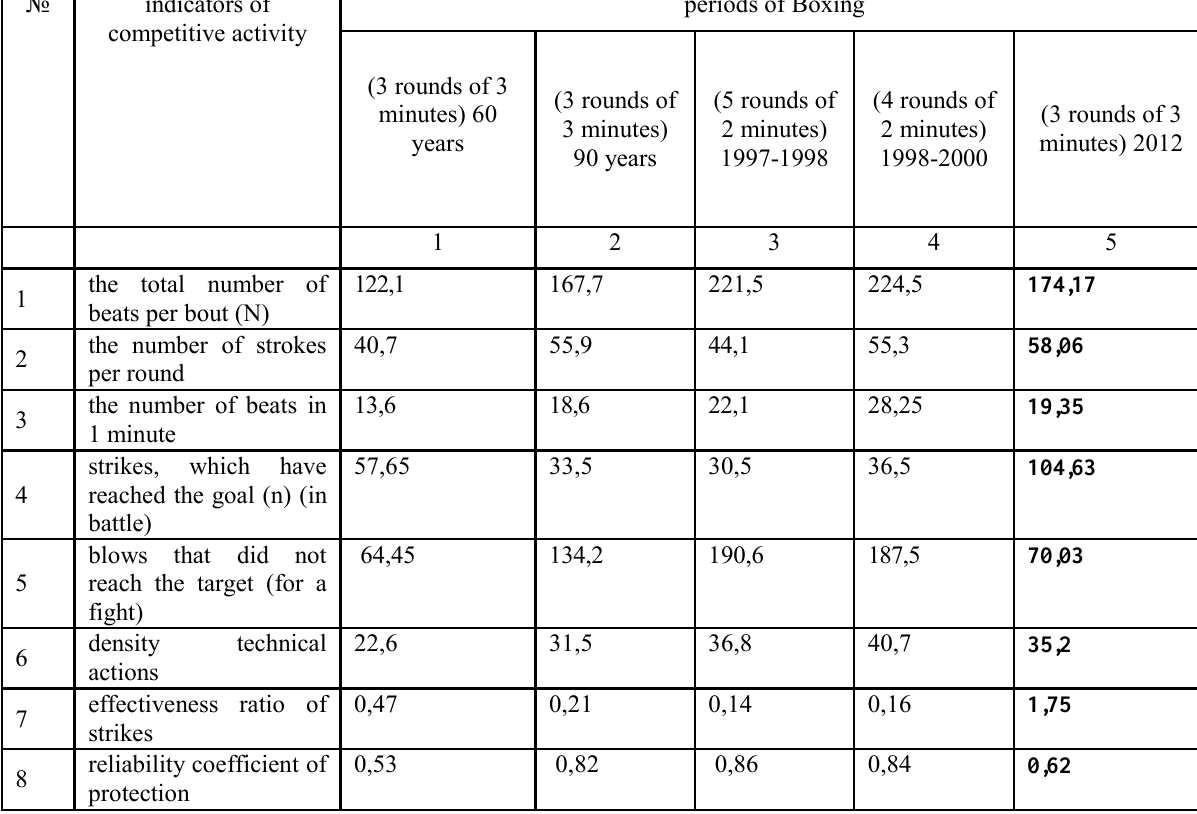
Indicators of competitive activity boxers’ qualifications at different periods of development of amateur